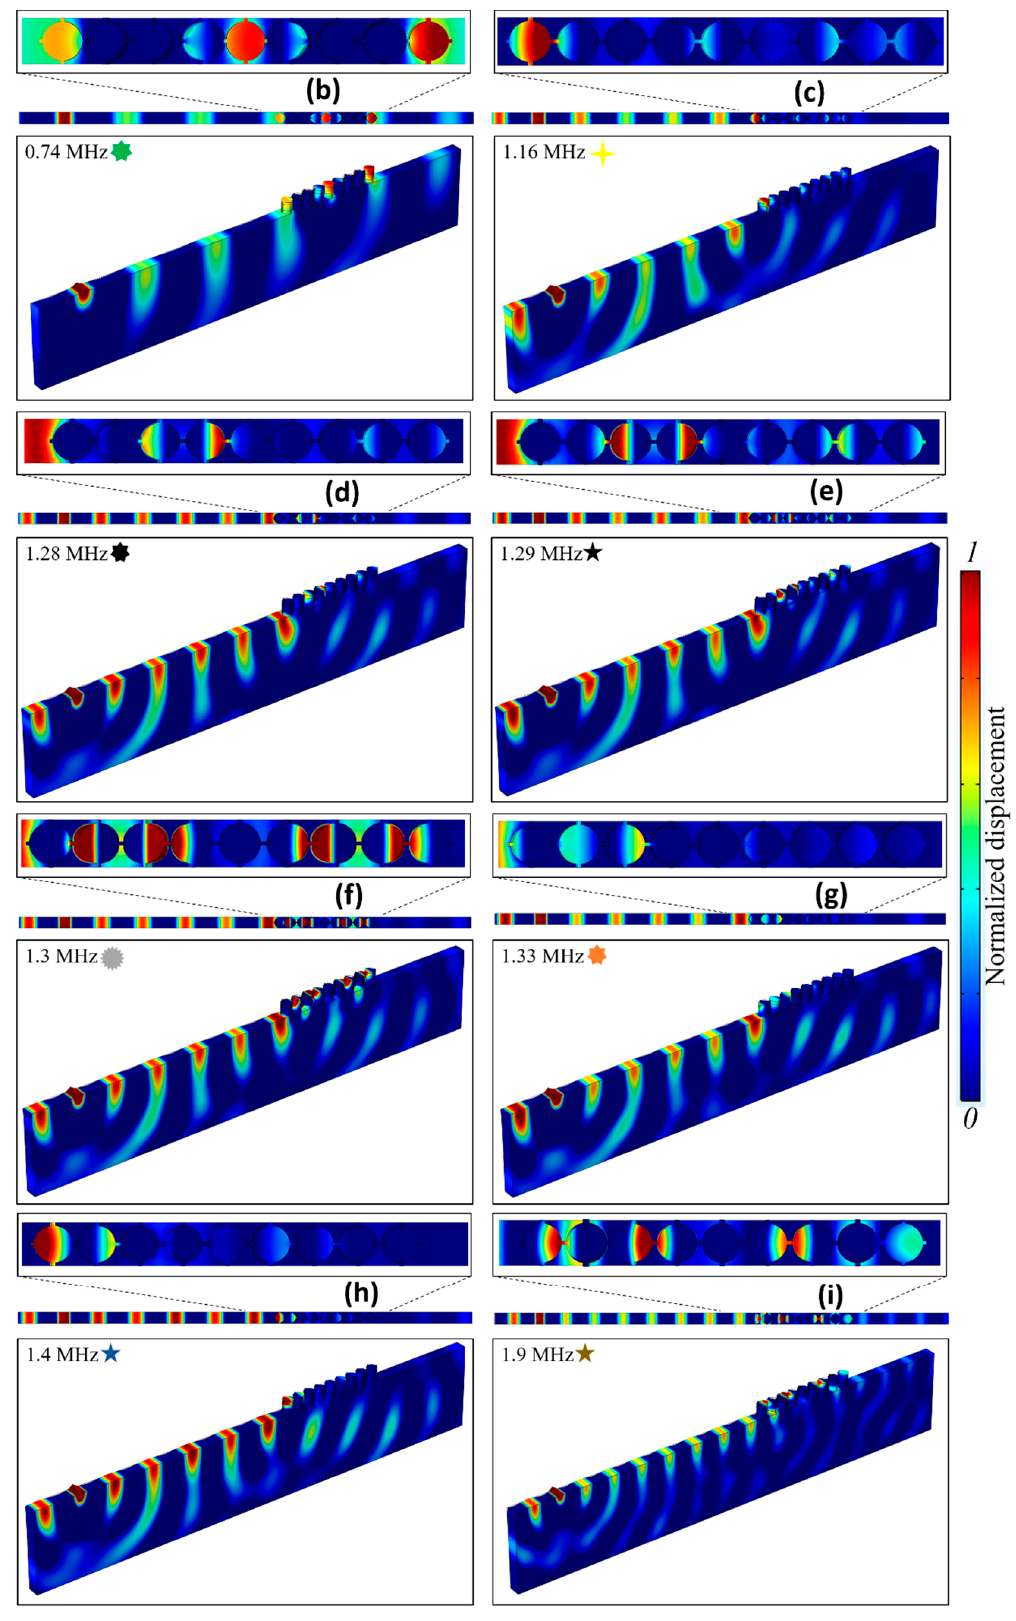
= Figure 8. SAW defect analysis for h 2 d = 0.2 a : ( a ) the schematic diagram in which the defect location is highlighted, and the Figure 8. SAW defect analysis for 2 0.2 d h a : ( a ) the schematic diagram in which the defect transmission curve is plotted. At defect position ( b , h ), SAW trapping ( c – e , f , g ) and vibration isolation with partial SAW location is highlighted, and the transmission curve is plotted. At defect position ( b , h ), SAW trap- propagation in neighboring parent cells can be ping ( c – e , f , g ) and vibration isolation with partial SAW propagation in neighboring parent cells can be seen.